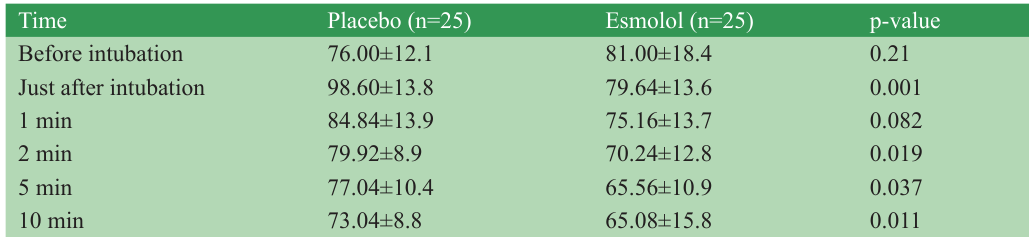
Table 8: Mean heart rate between placebo and esmolol group